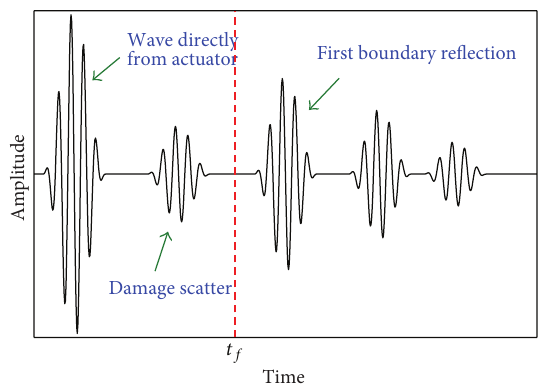
Figure 1: A typical Lamb wave signal includes wave that directly comes from actuator, damage scattering, and boundaries reflections.